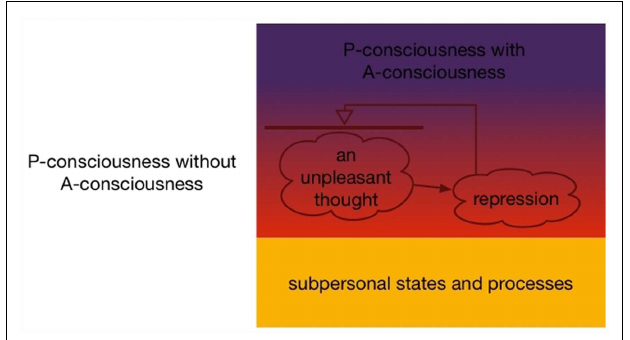
FIGURE 1 |The affective understanding of the M-unconscious. M-unconscious thoughts are affective P-conscious thoughts. Repression, which prevents the subject from being A-conscious of those thoughts, is itself a P-conscious, impulsive process of which the subject is not